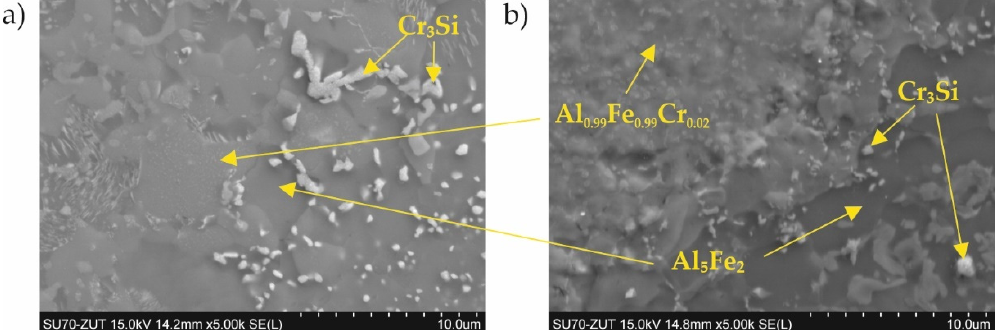
Figure 7. Microstructure of the sample with the coating manufactured at 800 °C, 2 h after ( a ) 51 h of nitriding; ( b ) 200 h of nitriding.